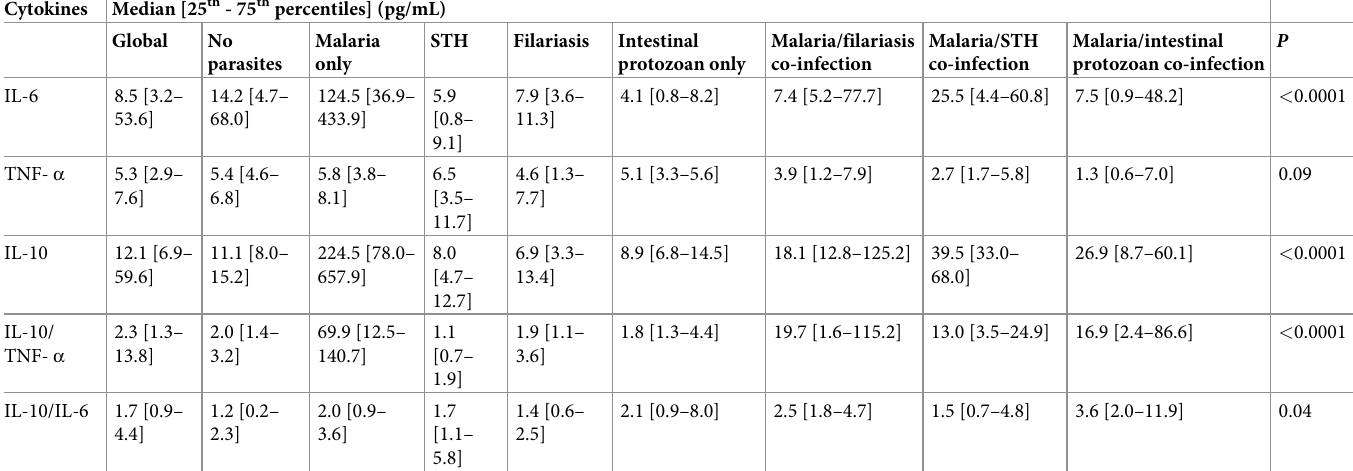
Table 2. Median levels of pro- and anti-inflammatory cytokines according to parasitic